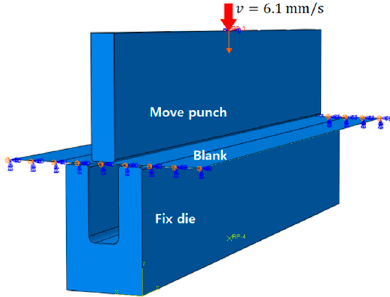
Figure 4. Boundary condition for blank, punch, and die.